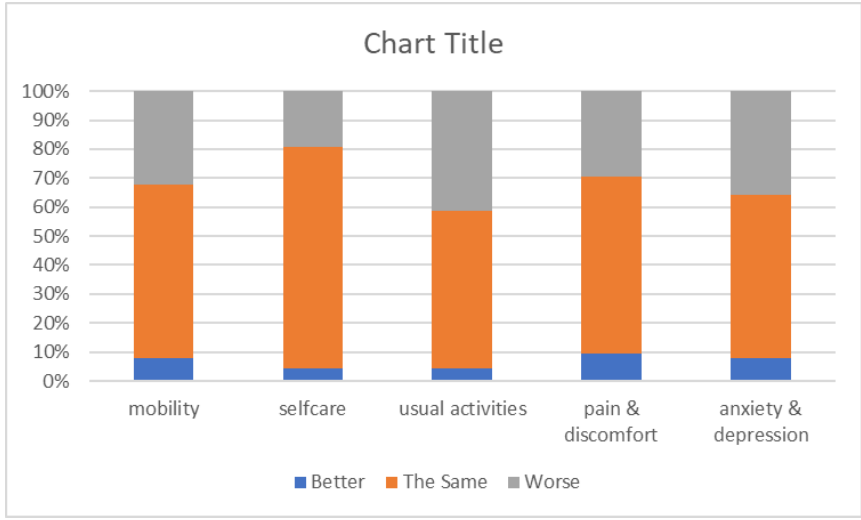
Figure 5. Change in EQ-5D domains reported for before COVID and at time of interview.